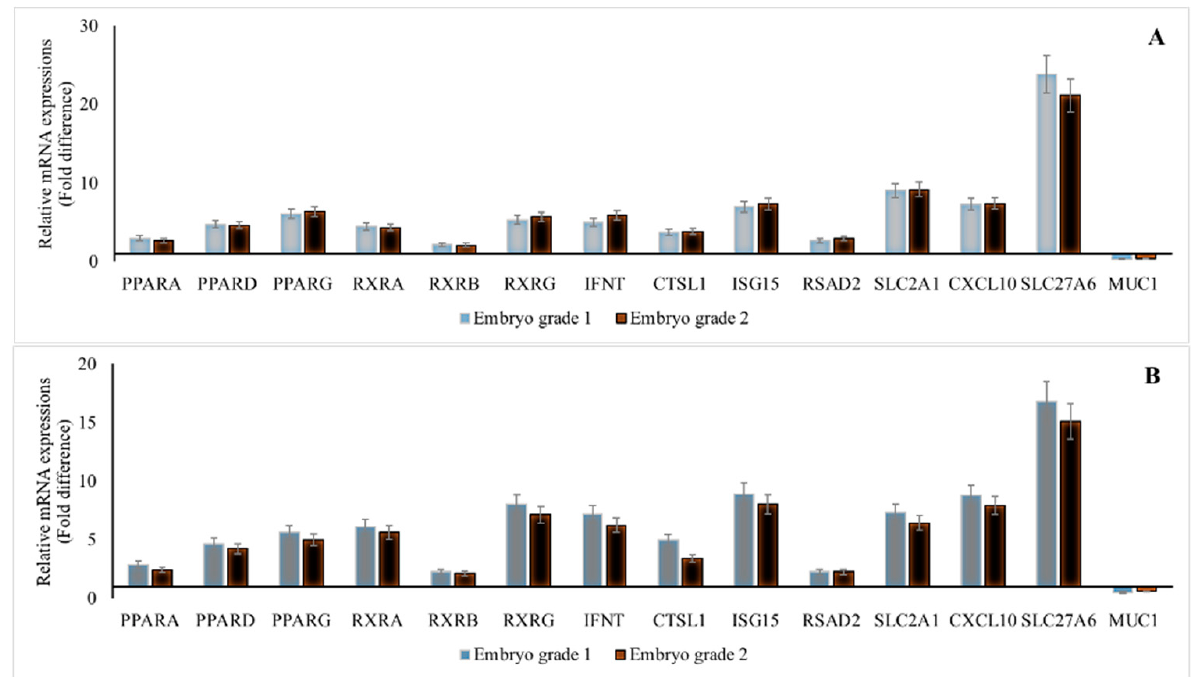
Figure 1. mRNA abundances in gestational day (GD) 16 embryo ( A ) and corresponding endometrium ( B ) of repeat breeder cows 1 following transfer of GD 7 embryo with Quality Grades (QG) 2 1, 2 and 3 (*). * Reference group (embryo QG 3) relative mRNA expression is 1-fold; all candidate genes were upregulated and MUC 1 was down regulated compared to reference group ( p < 0.05); 1 repeat breeder cows were with the history of failing to conceive after the first three inseminations post calving and documented pregnancy loss between 30 and 60 days following any of the first three services. 2